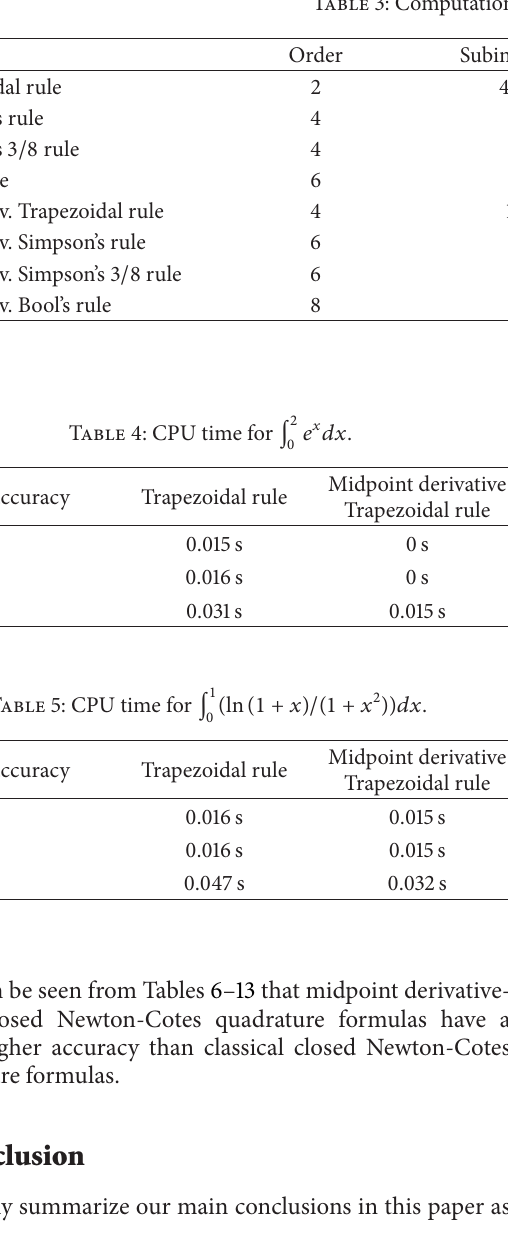
Table 3: Computational cost to estimate ∫